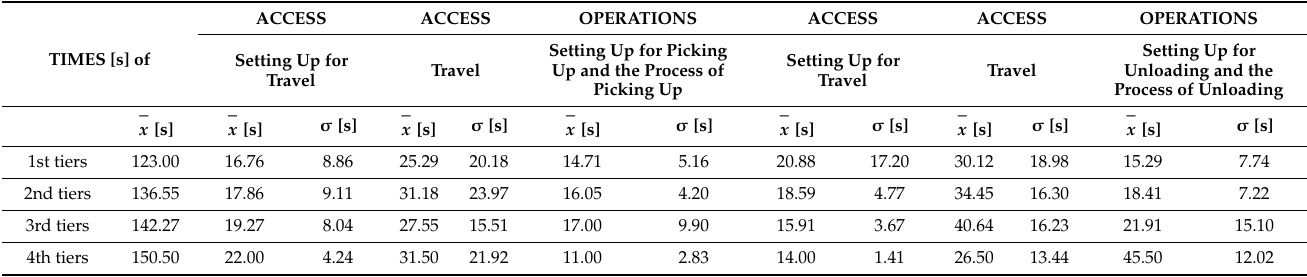
Table 1. Mean and standard deviations of times for particular